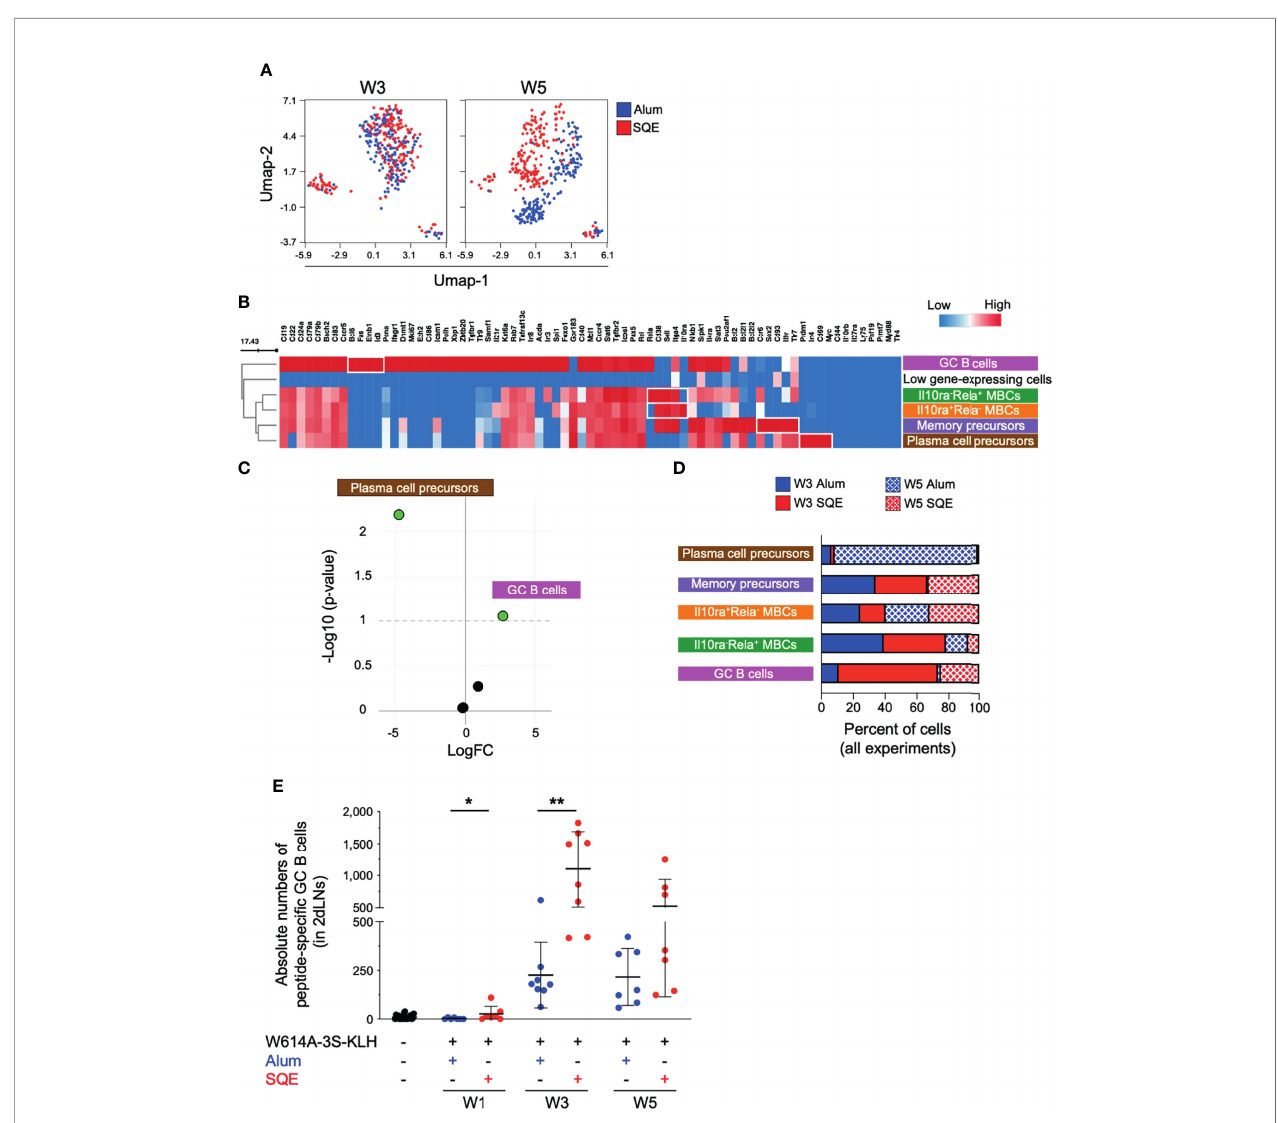
FIGURE 3 | Differential W614A-3S-speci fi c B cell populations after adjuvanted vaccination. Draining lymph nodes (dLNs; n = pool of 5 mice/condition - two independent experiments) were harvested at W3 and W5 after immunization and used to isolate peptide-speci fi c B cells and to perform single-cell gene expression analysis. (A) Uniform manifold approximation and projection (UMAP) plots were generated by concatenation of 747 single cells from Alum (blue) and SQE (red) condition across W3 and W5 for expression of 73 genes. (B) Heatmap showing the medians of gene expression (all time points) for six different clusters, distinguished using the FlowSOM algorithm. One represented cluster with few cells (38 of 747 cells) and low gene expression was removed. Gradient color: lower (blue) to high (red) expression. B cell subpopulation names are indicated. (C) Volcano plot [log fold change (FC) versus -Log10 (p-value)] depicting fi ve different clusters indicating empirical analysis of digital gene expression between adjuvanted conditions, with signi fi cant difference (p-value threshold <0.1; green points). (D) Graph represents cell percentages for each condition (Alum at W3, solid blue; SQE at W3 solid red; Alum at W5, wire blue; and SQE W5, wire red), based on 100% of evaluated cells [n = 97 plasma cell precursors; n = 224 memory-B cell precursors; n = 268 Il10ra + Rela - memory B cells (MBCs); n = 64 Il10ra - Rela + MBCs; and n = 56 germinal center (GC) B cells]. (E) A dot plot with mean ± SD (n = 7 – 13) represents the absolute numbers of W614A-3S-speci fi c GC B-cells in two dLNs, at W1, W3, and W5. Statistical analyses were carried out using the Mann – Whitney U test and statistical signi fi cance is indicated between adjuvanted conditions: *p < 0.05; **p <